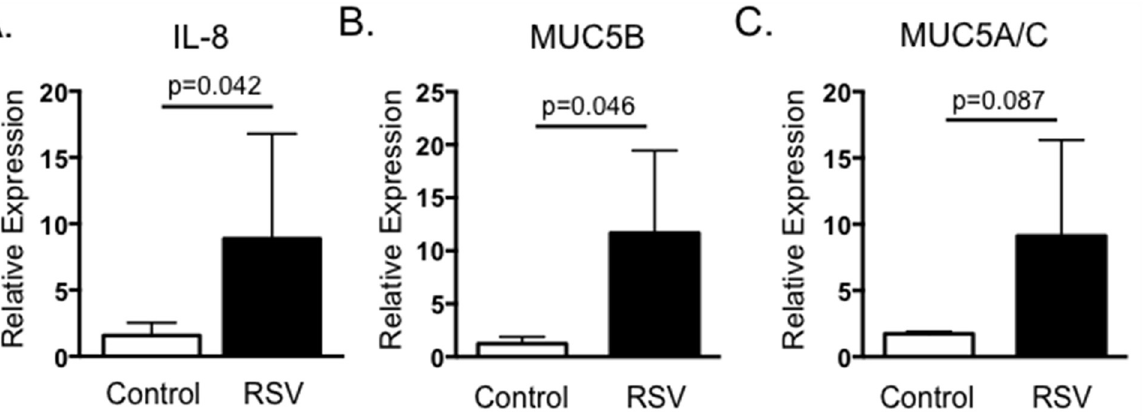
Fig 3. Cell culture supernatants from BRSV stimulated PBMC induce expression of IL-8, MUC5B and MUC5AC by BT cells. PBMC from control (nonvaccinated) and BRSV vaccinated cows were isolated and stimulated with heat-killed BRSV for 6 days as in Fig 2. Cell culture supernatants were then diluted 1:1 in cMEM and added to confluent BT cells in 96 well plates for 24 hours. RNA was the isolated from the BT and analyzed by qPCR for expression of IL-8 (A), MUC5B (B) and MUC5AC (C). For qPCR analysis, results were normalized to the housekeeping gene RPS-9, and expressed relative to unstimulated control samples. Results were pooled from two independent experiments. Data represent means ± SEM.